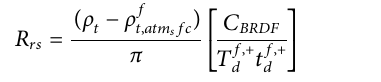
> 30 and χ 2 < 2 to v